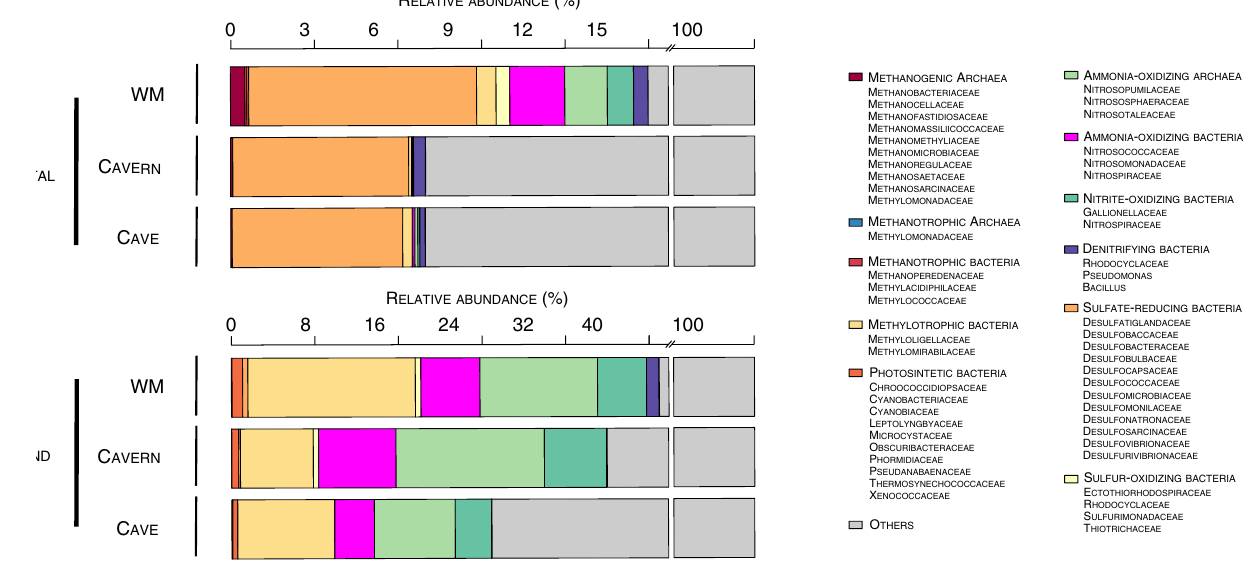
Figure 4. Relative abundance of the functional groups in the three sediment zones from coastal and inland sinkholes. WM, water mirror.